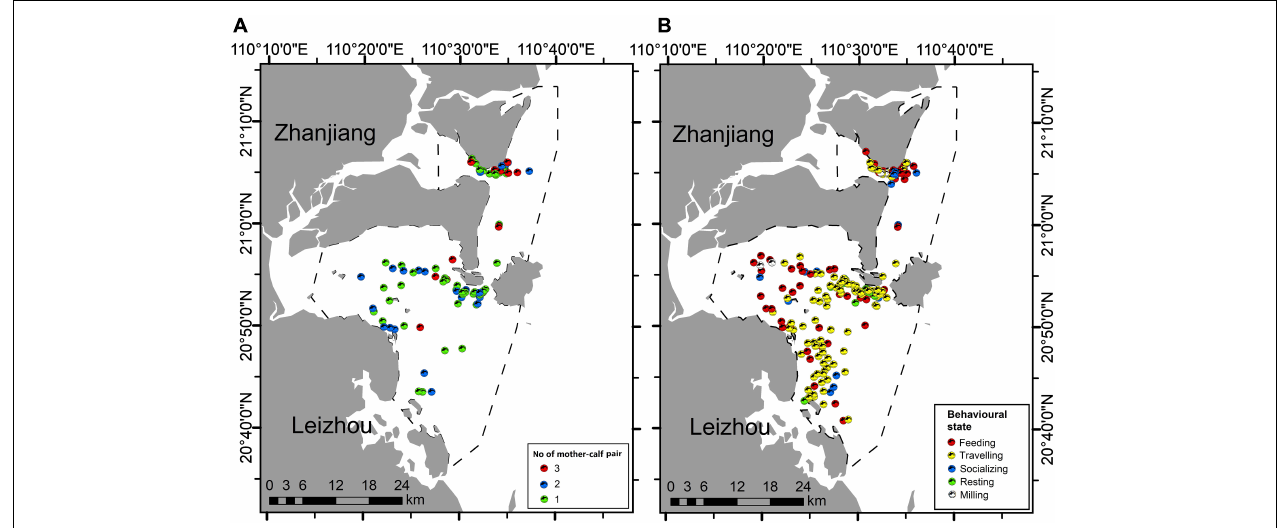
TABLE 3 | Generalized linear models (GLMs) built to determine potential temporal (year, season, and tide) and/or behavioral effects (number of mother-calf pairs, and behavioral state) on group sizes of Indo-Pacific humpback dolphins in the eastern waters of Zhanjiang, China. Source of variation Type III sum of squares df Mean square F P Corrected model 10,287.9